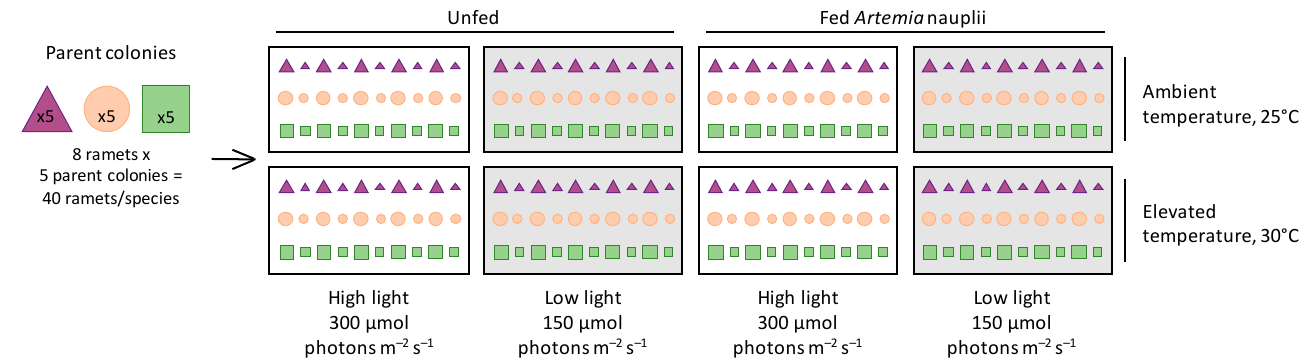
Figure 1. Experimental design schematic. Five parent colonies of Pocillopora damicornis , Stylophora pistillata , and Turbinaria reniformis were fragmented into eight large and eight small ramets and distributed randomly and evenly among eight treatments of a fully factorial experimental design: two seawater temperatures (ambient temperature of 25 °C, elevated temperature of 30 °C), two light levels (high light of 300 μ mol photons m –2 s –1 , low light of 150 μ mol photons m –2 s –1 ), and either fed ( Artemia nauplii) or unfed.